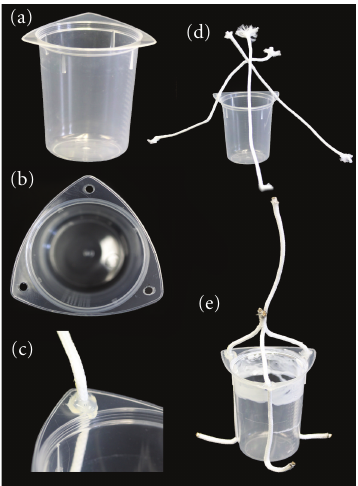
Figure 6: Cup trap design: (a) tricorner beaker, (b) holes bored in flange of beaker, (c) cotton rope threaded through flange hole and secured with hot glue, (d) cotton ropes linked together using nylon rope above trap, and (e) completed trap with excess cotton rope below lip of flange taped to sides of beaker (cup).